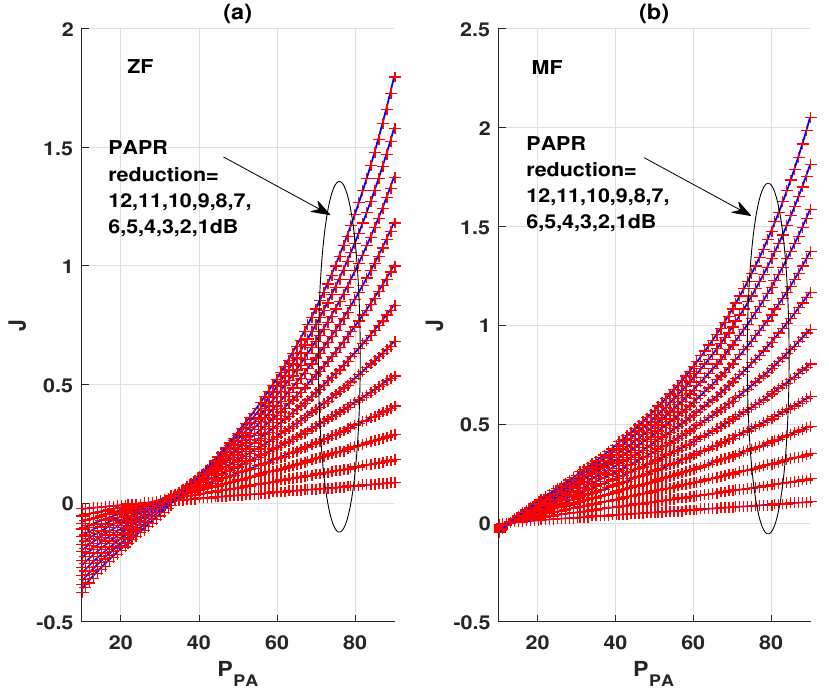
Figure 5. J versus P PA , ( a ) ZF precoding, ( b ) MF precoding, when N t = 400, K = 40. Lines are based on analysis from Equations (19) and (20), and red ‘+’s are simulation